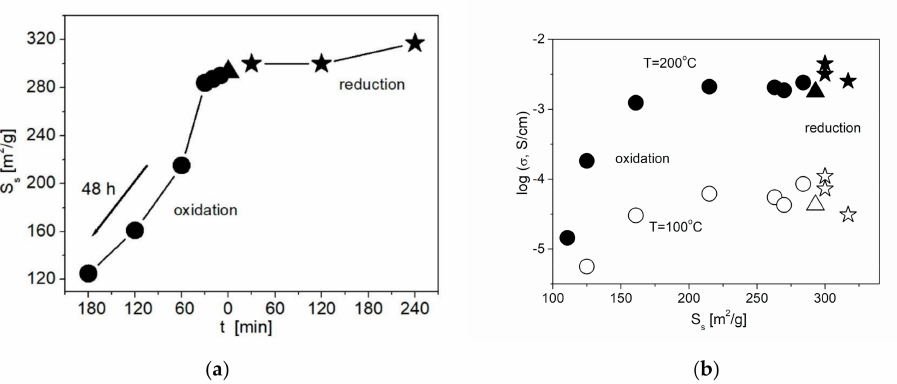
Figure 5. Change in the specific surface area of NDs ( a ) and the conductivity of 0.1CsNO 2– 0.9ND composites ( b ) with the treatment time for various methods of ND functionalization. Data for samples containing unmodified NDs, ND Acid and ND H2 are denoted by triangles, circles and stars,